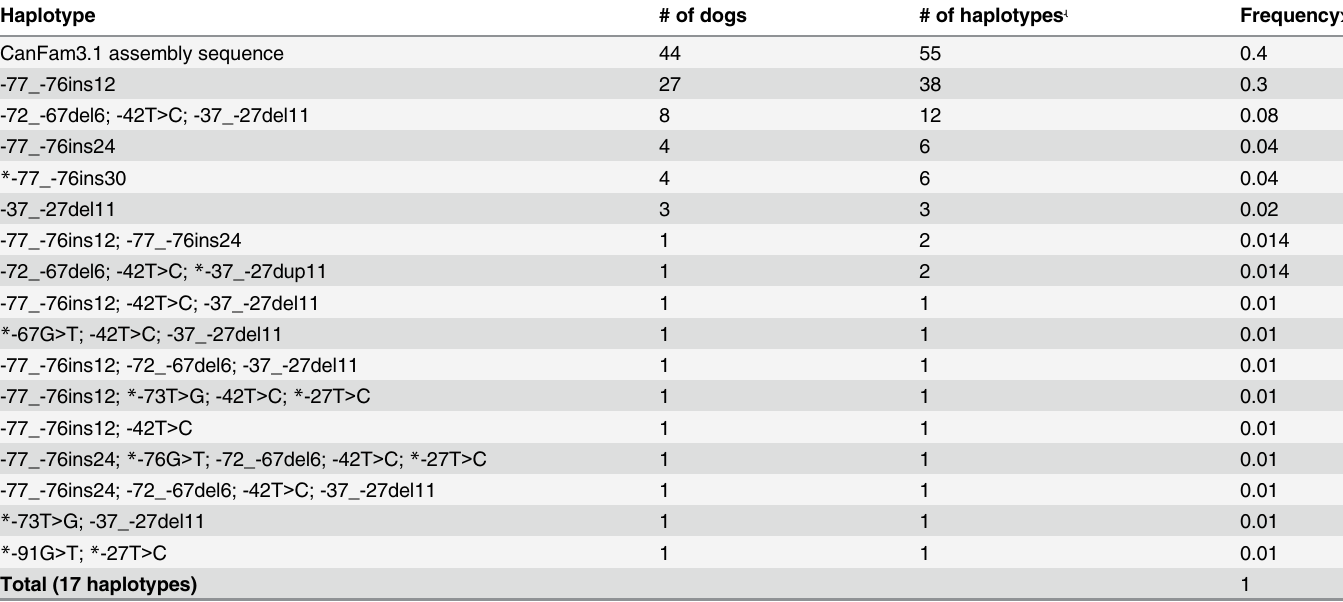
Table 1. 5 ’ UTR Cox-2 variants found in 68 dogs free of renal disease *